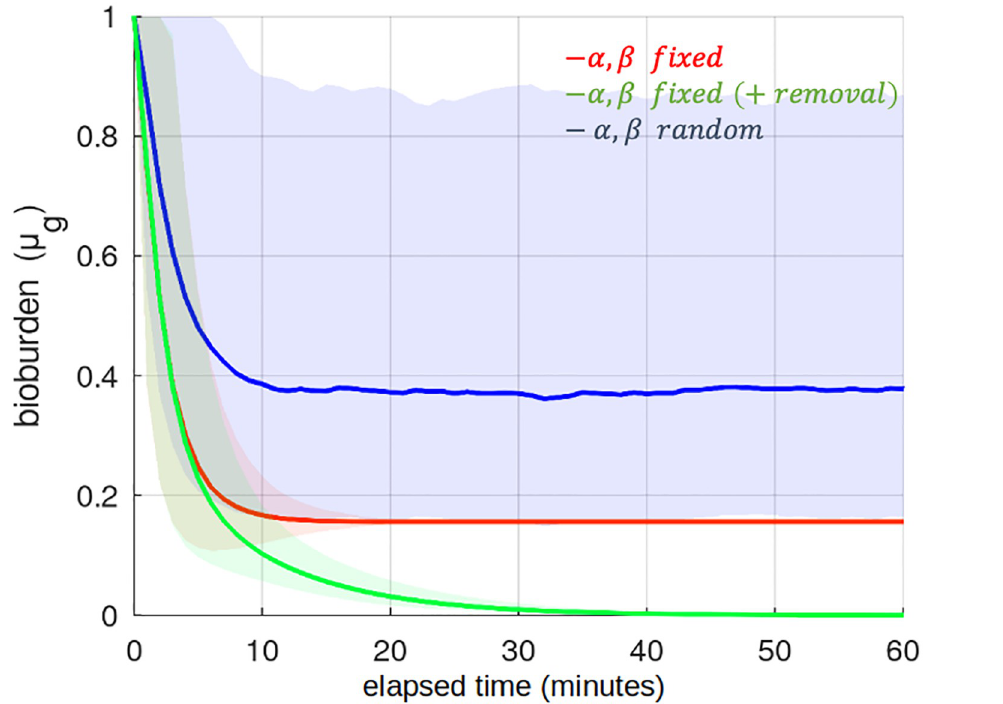
Fig 3. Dynamic equilibrium of surface bioburden. A single individual (with clean hands) continuously touches a surface at the same location(s) e.g. the ‘buttons’ on a TUI. The geometric mean and standard deviation (GSD) of surface bioburden is depicted with three variations of the pickup/deposit rate model: fixed parameters ( α = 0.05, β = 0.27) with (green) and without (red) loss due to pathogen decay/die-off, and (blue) random parameters α * f tn (0.05, 0.3, 0, 1) (median average 0.22) and β * f tn (0.27, 0.3, 0, 1) (median average 0.34) where f tn ( μ , σ , a , b ) is a truncated normal distribution on the domain [ a , b ]. The plots are consistent with Eq 4, which predicts an equilibrium point of 0.15 for the fixed parameter case and � 0.40 for random parameters. Once pathogen loss is incorporated, all levels tend to 0 over